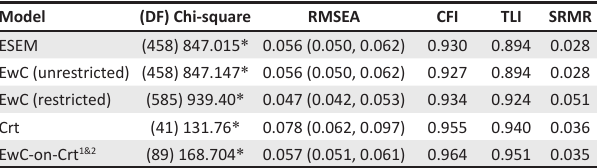
TABLE 2: The model fit indices for the structural equation models tested in the study.